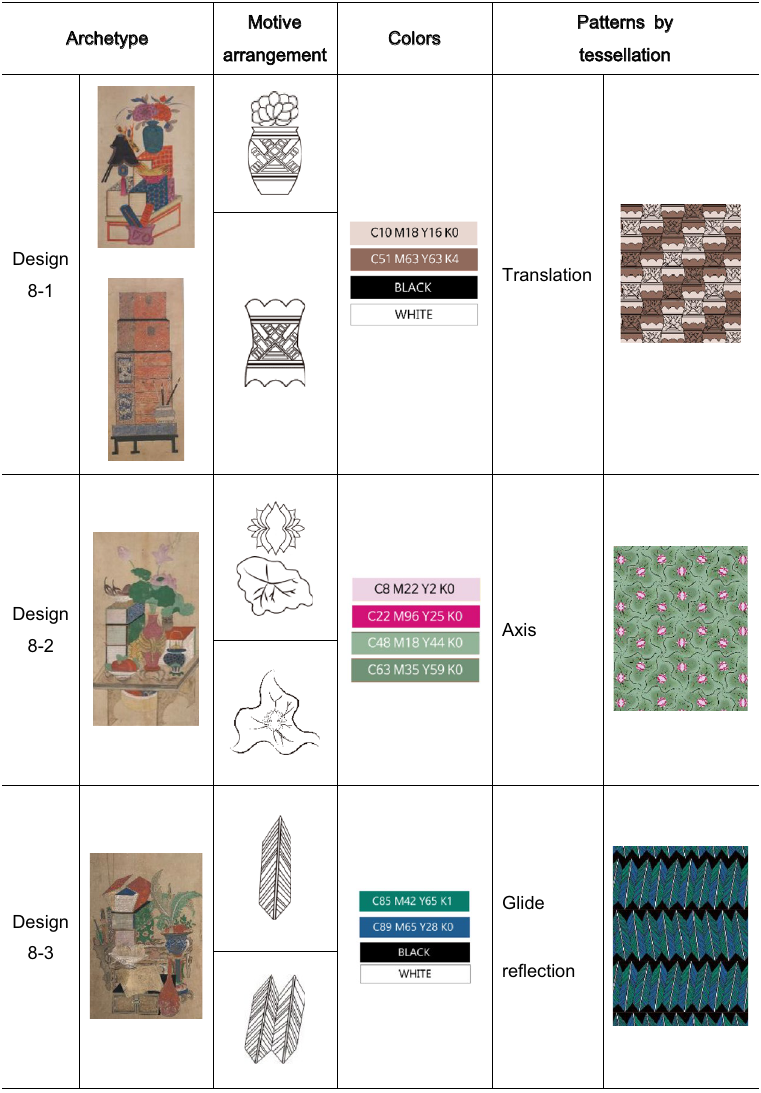
Table 8 Textile pattern design using wealth